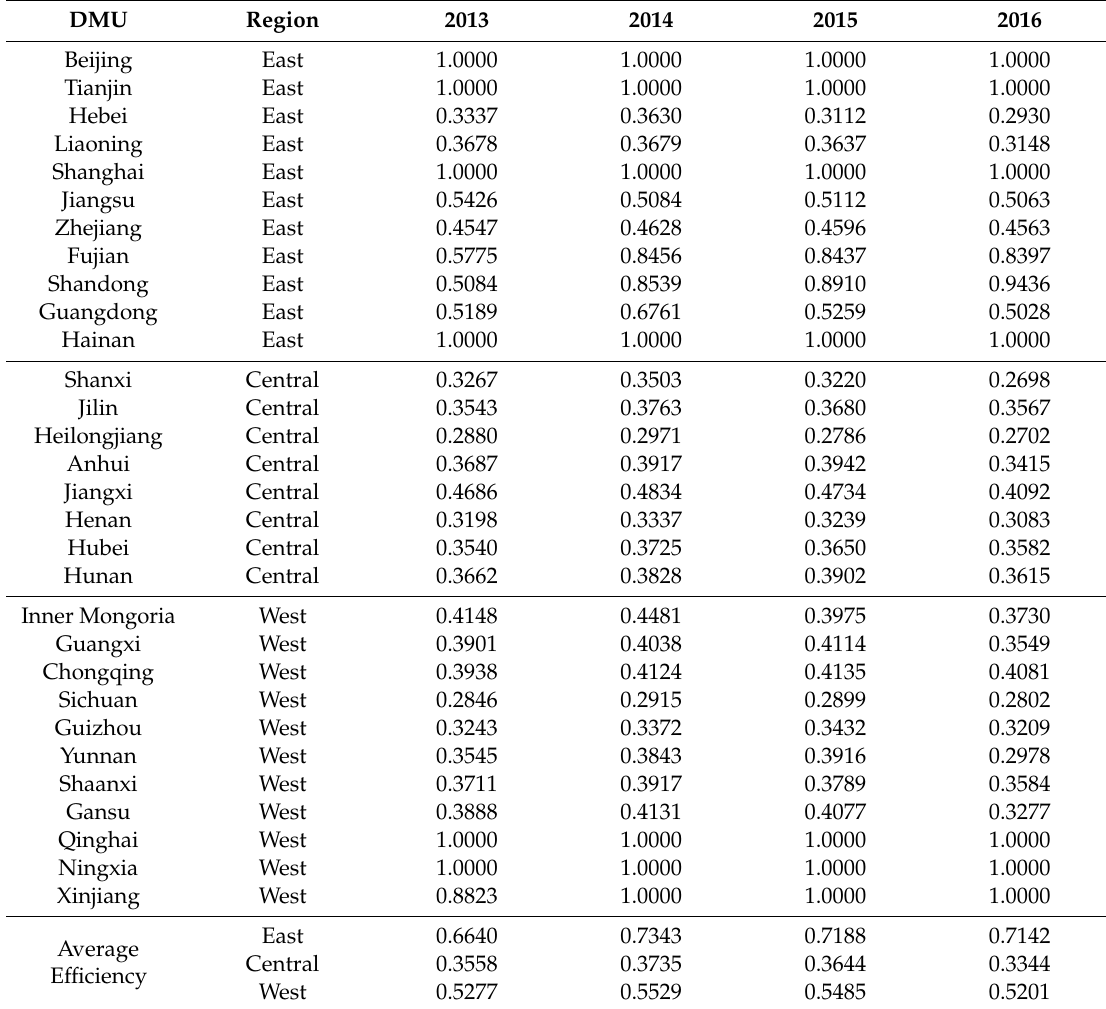
Table 2. Overall e ffi ciency of each